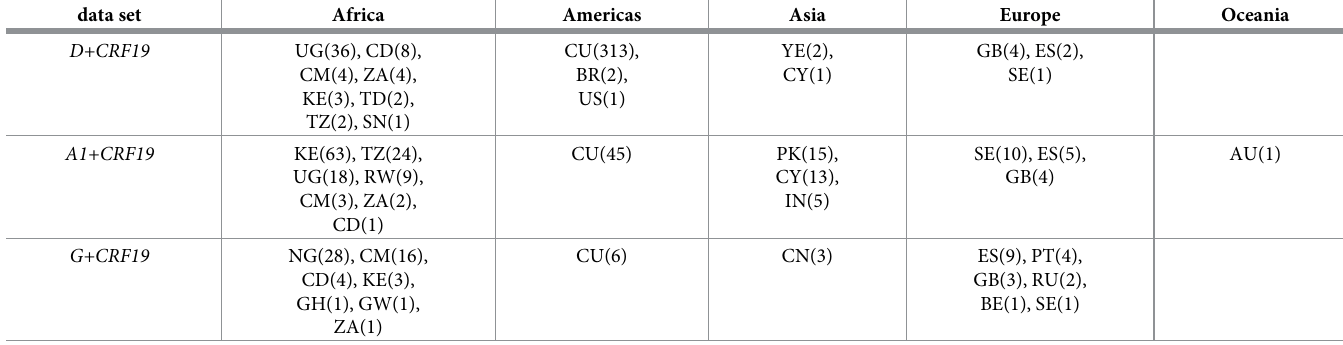
Table 2. Data set description: Locations. Number of sequences from different locations. data